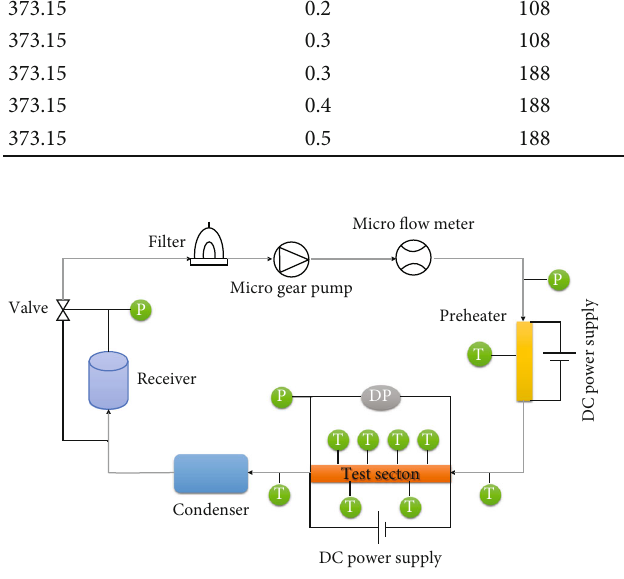
Figure 4: Schematic diagram of experimental apparatus for fl ow boiling loop.